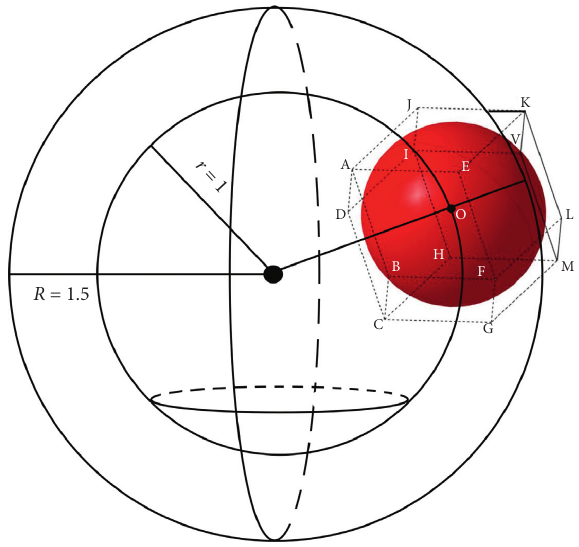
Figure 4: Size of a rhombic dodecahedron outside G